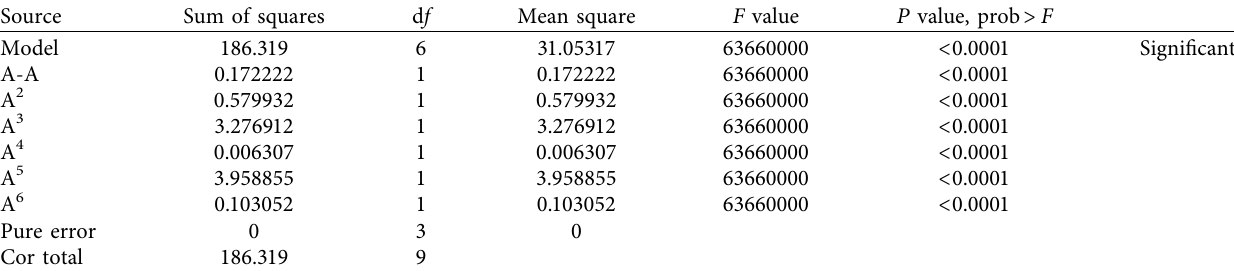
Table 10: ANOVA analysis of neat PLA